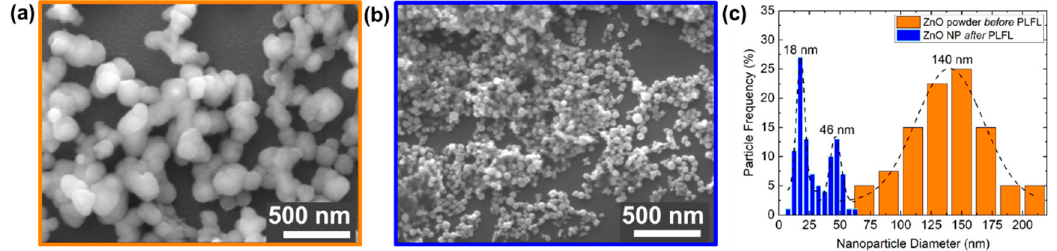
Figure 3. SEM micrographs of ZnO nanoparticles (NPs) ( a ) before and ( b ) after pulsed laser fragmentation in liquid (PLFL) processing; ( c ) ZnO nanoparticle size distribution both before and after PLFL.